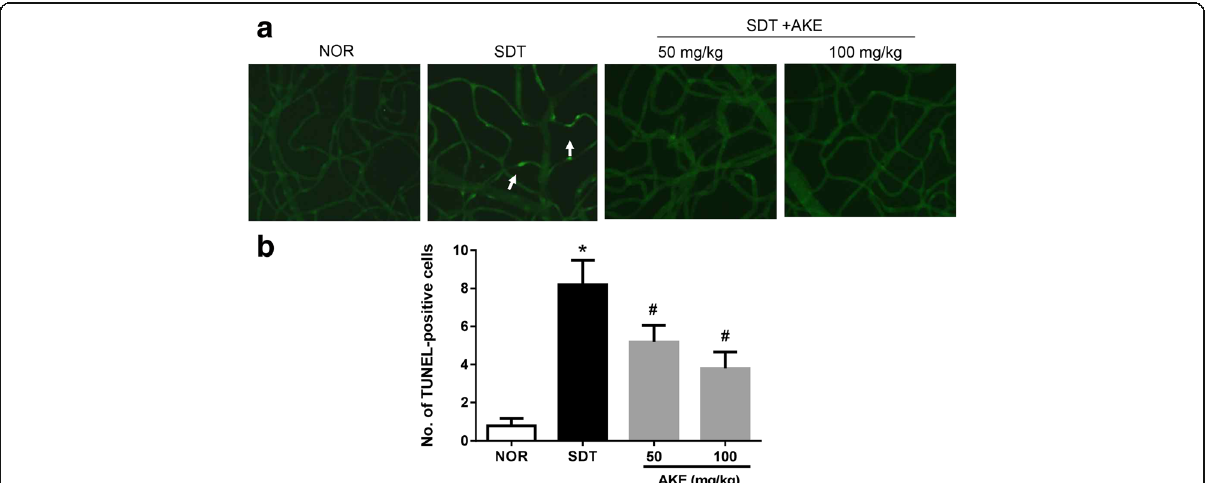
Fig. 3 Retinal vascular cell apoptosis. a The trypsin-digested retinal vessels were stained with TUNEL. Arrows indicate that apoptotic cell death occurred in the SDT rats. b Quantitative analysis of the TUNEL-positive nuclei. Values in the bar graphs represent the mean ± SE, n = 5. * p < 0.05 vs. NOR, # P < 0.05 vs. SDT